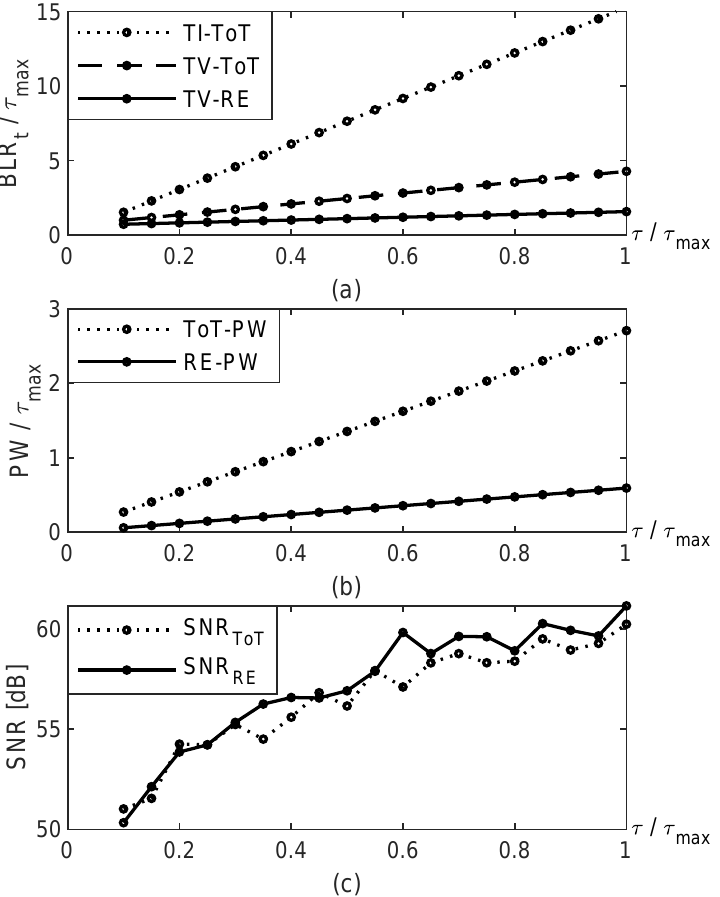
Figure 7. ( a ) BLR t versus τ of the analog-channel for TI-ToT, TV-ToT and RE techniques; ( b ) the pulse width of ToT and RE signals versus τ ; and ( c ) SNR RE and SNR ToT versus τ . All are plotted for V TH = 0.8 × V p , V THE = 0.4 × V p and σ noise = 0.03.